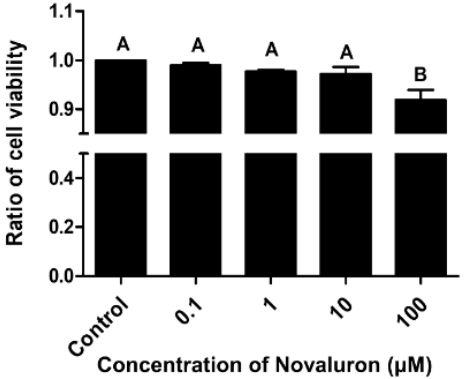
Figure 1. Effects of novaluron on cell viability. Cell viability after exposure to different concentrations of novaluron. Data represent mean ± SEM, n = 4. Data were evaluated by one-way ANOVA and represent mean ± SEM, n = 4. Values with different superscripts ( A,B ) indicate significant differences between the control and treatment groups ( p < 0.05).